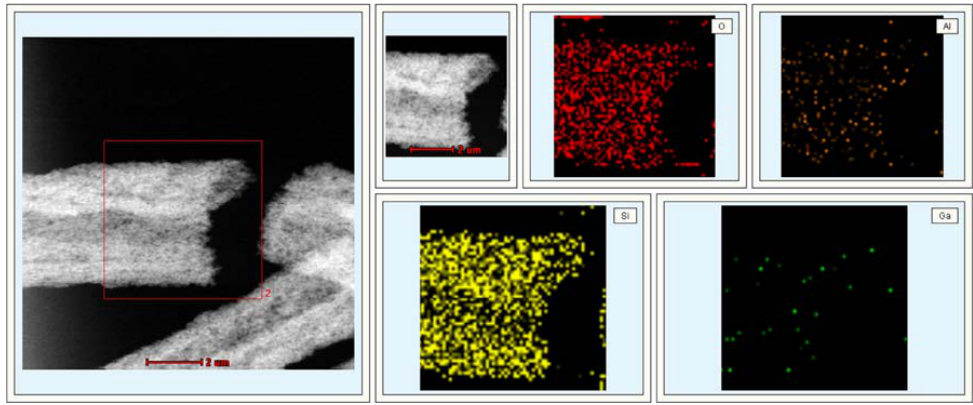
Figure 4. EDAX elemental maps of Si, O, Al, and Ga of 0.3% Ga 2 O 3 /ZSM-5 zeolite hollow fibers. Figure 5 shows the nitrogen adsorption-desorption isotherms and BJH pore size distribution (inset) of the Ga 2 O 3 /ZSM-5 hollow fibers. According to the nitrogen adsorption-desorption measurement, the Brunauer-Emmett-Teller (BET) surface area of 377 m 2 /g and the pore volume of 0.275 cm 3 /g were determined. From Figure 5, it can be seen that the present isotherms exhibit a typical hysteresis loop at p / p 0 > 0.1, indicating mesopores are formed, arising from the interparticle voids of Ga 2 O 3 /ZSM-5. Hence, the as-prepared Ga 2 O 3 /ZSM-5 hollow fibers exhibit a good hierarchical macro-meso-microporosity, with micropores in ZSM-5 nanoparticles, mesopores formed by the stacking of the Ga 2 O 3 /ZSM-5 nanoparticles, and continuous macropores on the hollow fibers.